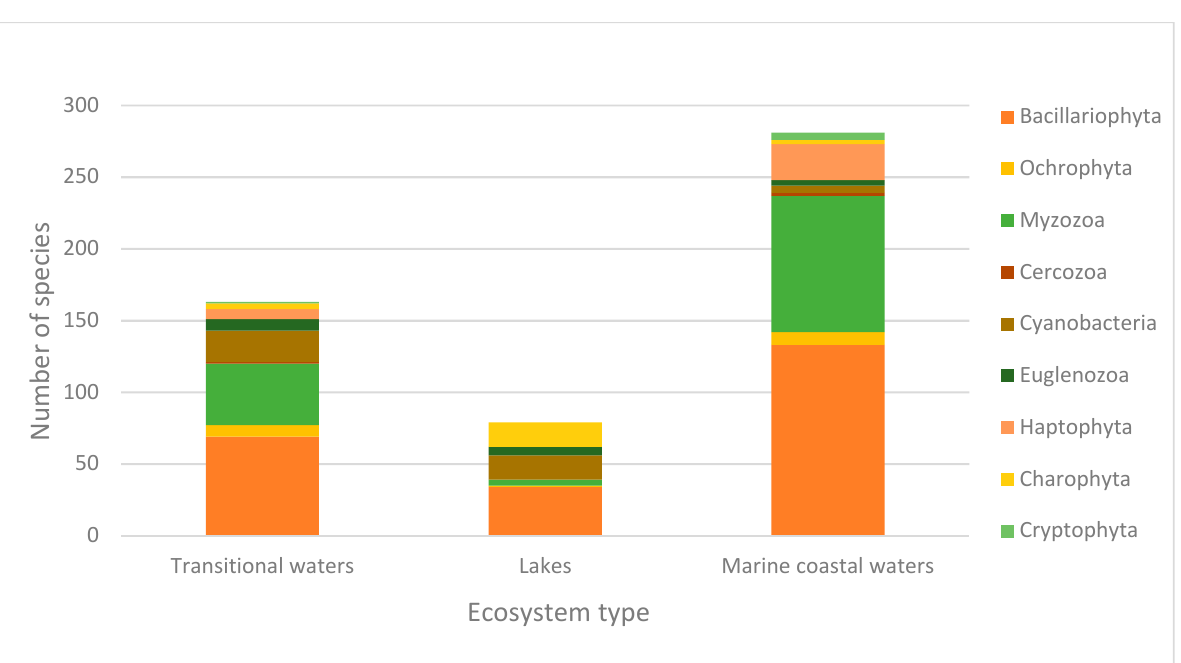
Figure 3. Number of species without a COI barcode for the different phyla in transitional waters, lakes, and marine coastal waters .